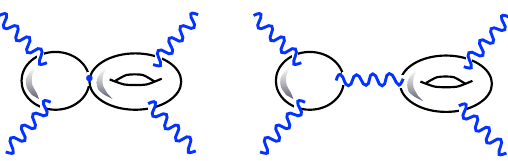
Figure 2 . The distinction between \delta function" and \delta function and